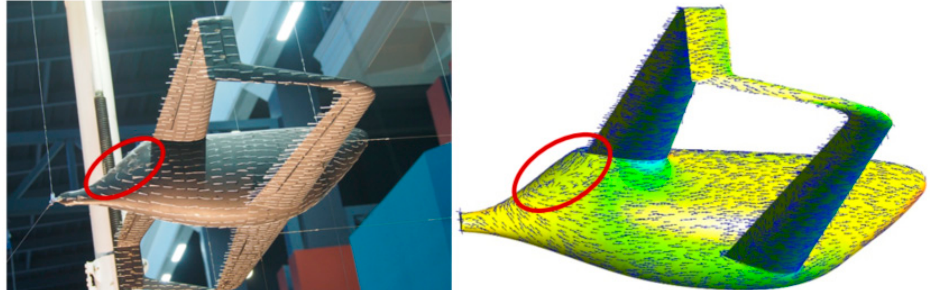
Figure 13. The scale model of a light boxplane in T-1 wind tunnel and the CFD visualization. Test conditions: α = 0°, β = 0°. Red oval indicates the crossflow on the bottom aft fuselage.